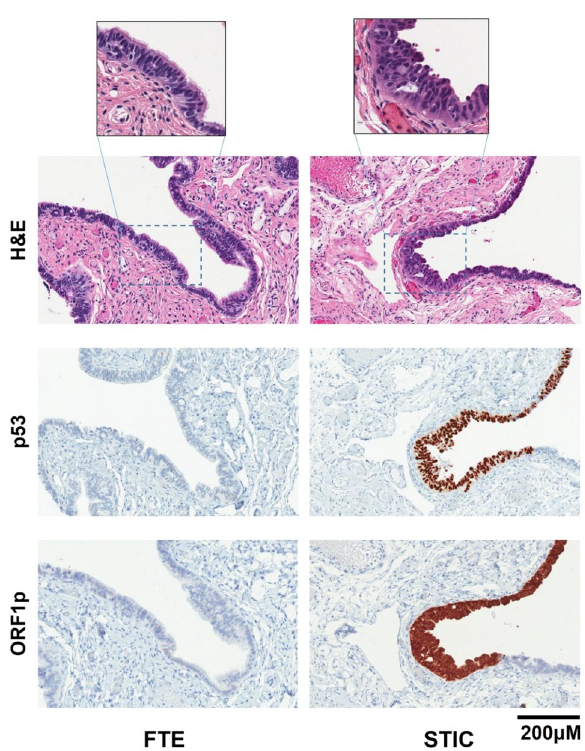
Figure 4. LINE-1 ORF1p is expressed in incidental STIC lesions. Representative images of hematoxylin and eosin (H&E) staining, p53, and LINE-1 ORF1p expression in fallopian tube epithelium (FTE) and serous tubal intraepithelial carcinoma (STIC) lesions (IHC). Incidental STIC lesions display robust cytoplasmic and pan- cellular ORF1p expression (20X). There is no ORF1p expression in the adjacent benign epithelium.